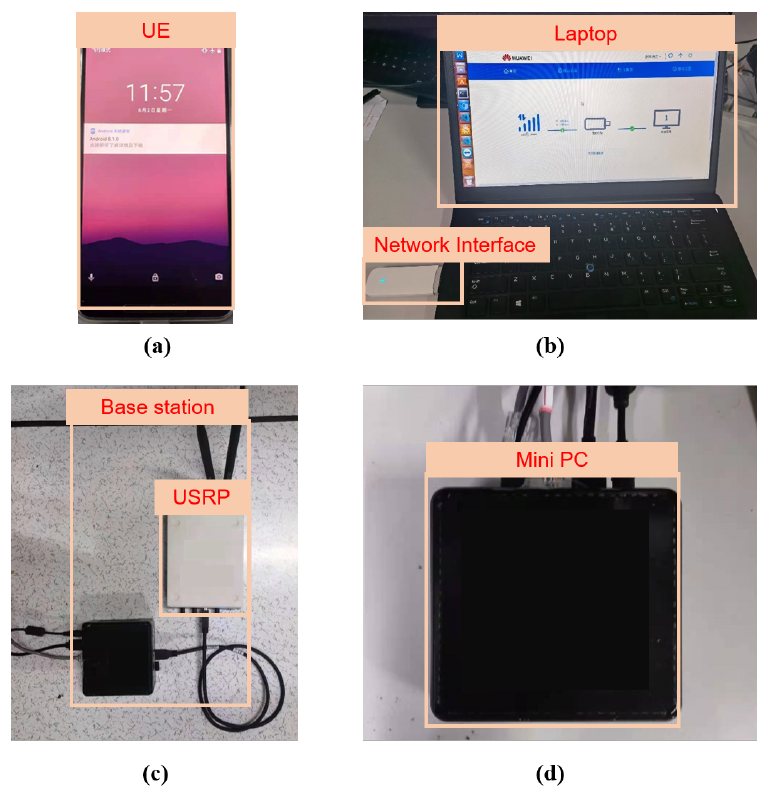
Figure 6. The pictures of the prototype system. ( a , b ) are two types of commercial UE, ( c ) is the software-defined base station with frequency front-end USRP, and ( d ) is the mini PC.